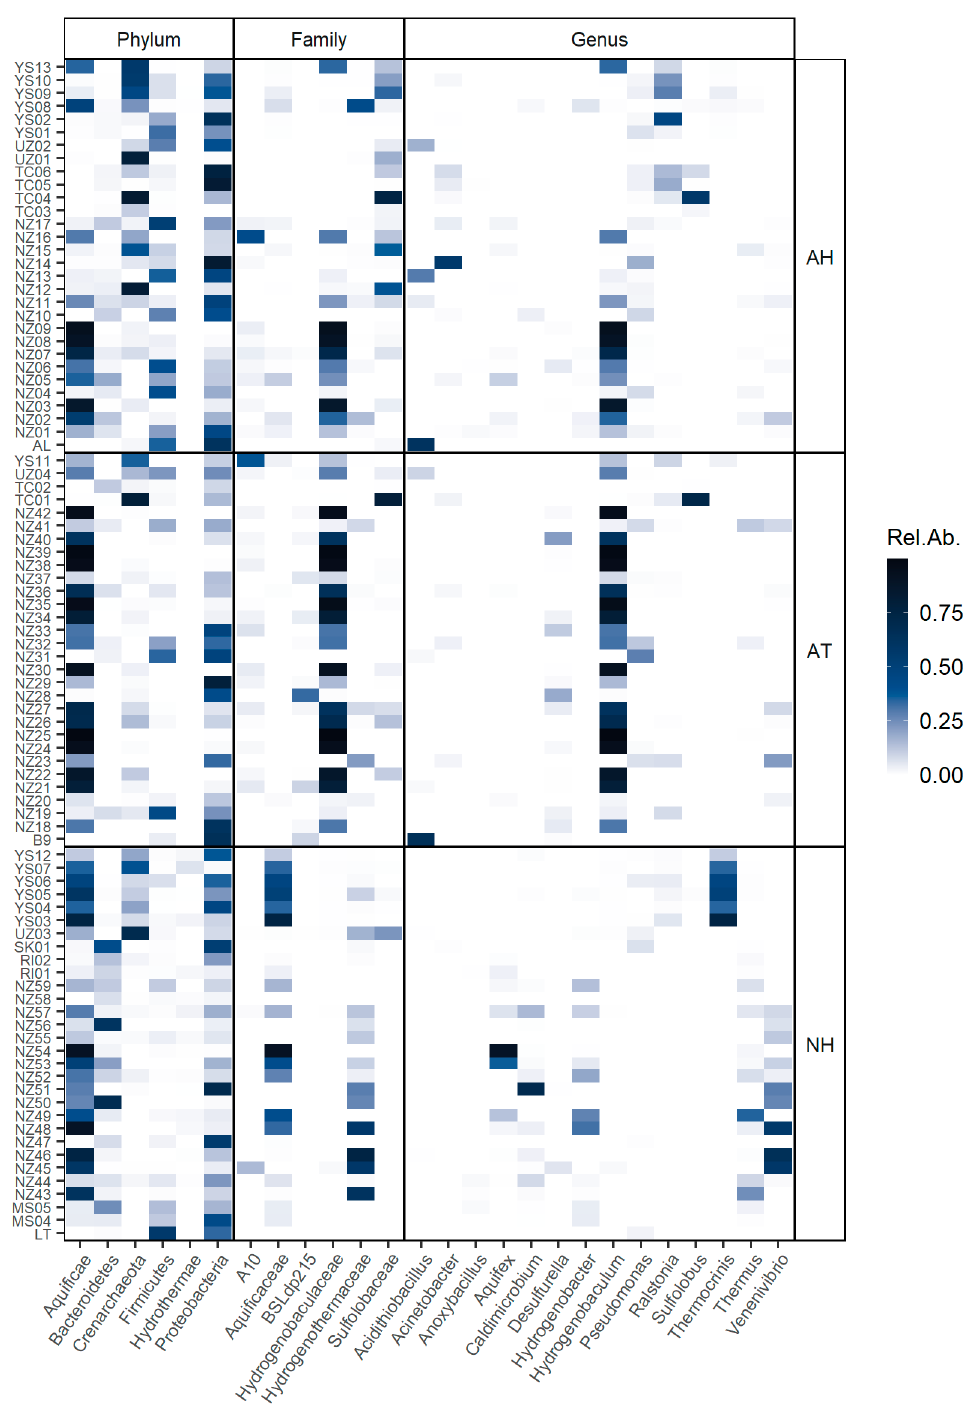
Figure 5. Heatmap of the relative abundance of taxa at different ranks across samples and conditions. Taxa are named and ranked (x-axis) are according to the Silva database. Sample names (y-axis) are fully described in Supplementary Table S1. The first two letters of each sample name correspond to the location of the sample: Malaysia (MS); New Zealand (NZ); Raoul Island, New Zealand (RI); Sikkim, India (SK); Tengchong, China (TC); Uzon Caldera, Russia (UZ); and Yellowstone National Park, USA (YS). LT, B9 and AL are the samples from Caviahue-Copahue and Domuyo described in this study. Sample conditions are described as acidic and hyperthermophilic (AH), acidic and thermophilic (AT) or circumneutral and thermophilic (NH).